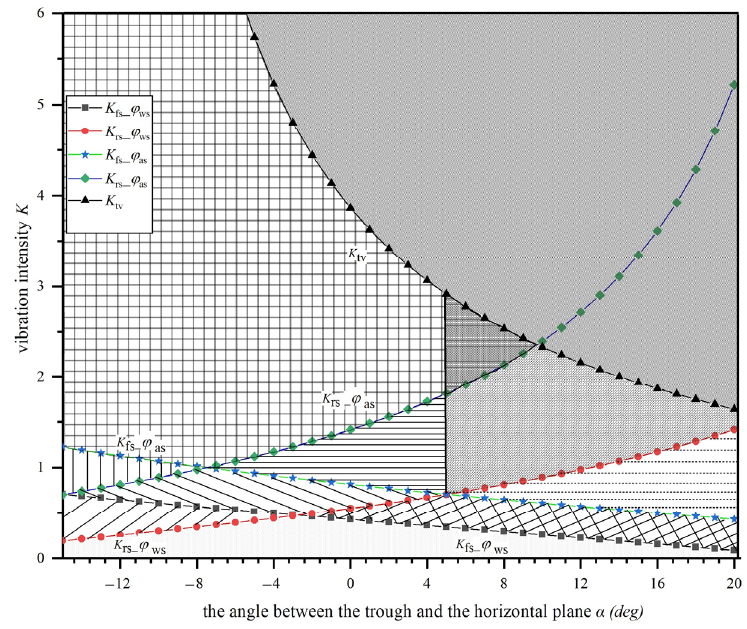
Figure 5. Fry Movement Relationship Chart.